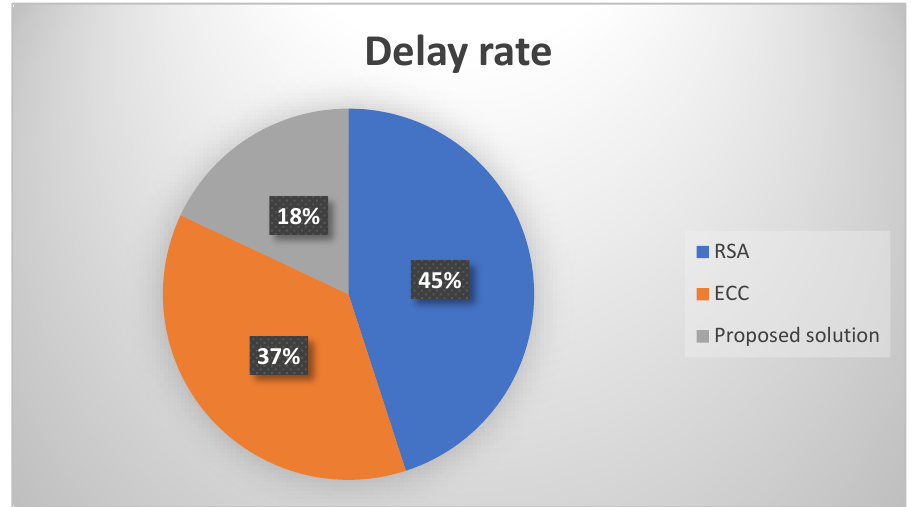
Figure 16. Delay rate of transmission.